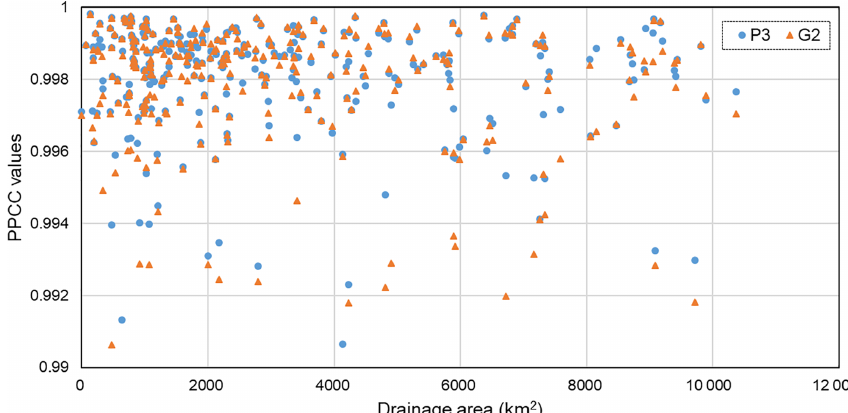
Figure 9. The spatial distribution of best daily precipitation distribution function.